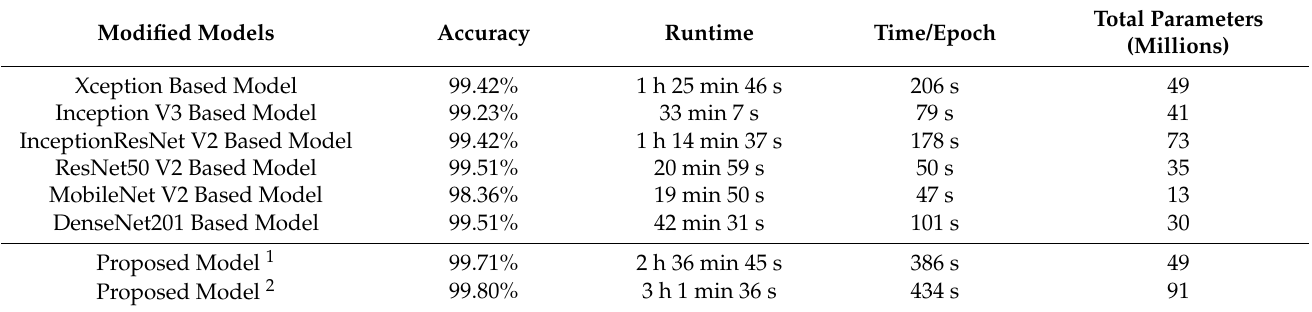
Table 15. Models runtimes and time by epoch description.